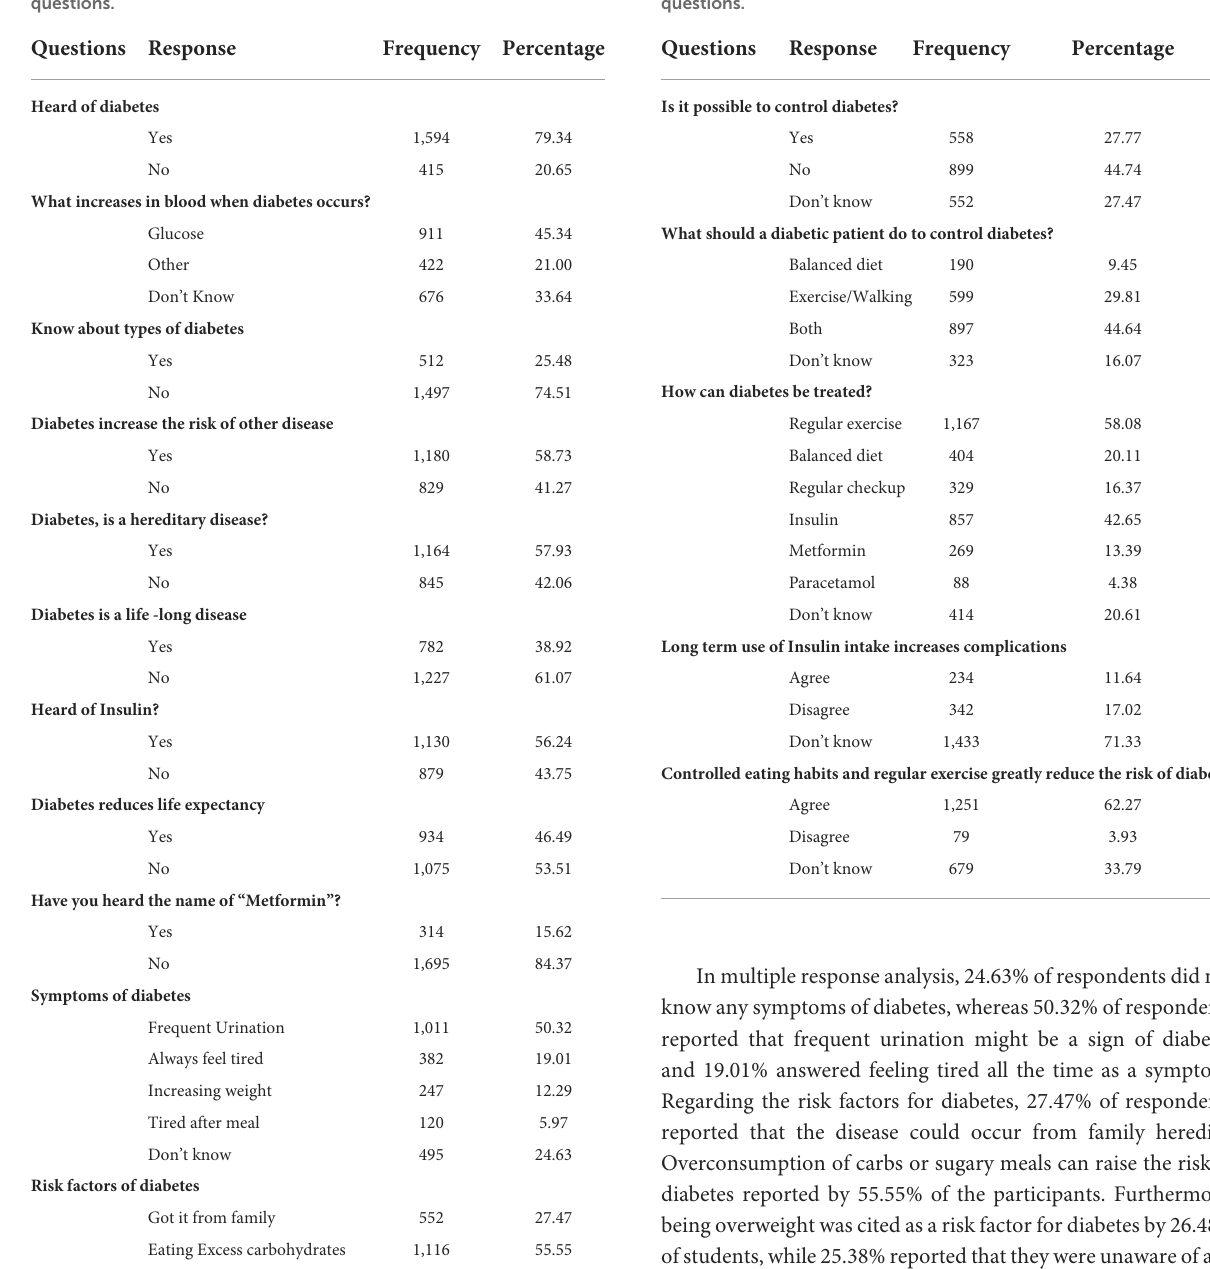
TABLE 2 Frequency distribution of the responses to knowledge questions.